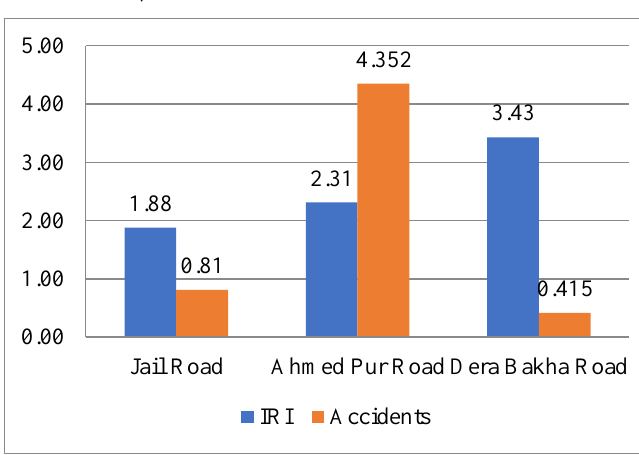
Fig. 7. Bar Chart Comparing IRI and Accident Data (1/1000